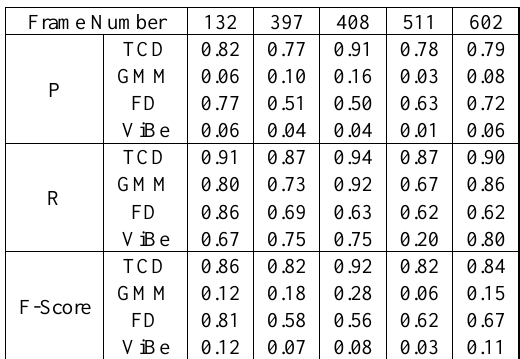
Table 2. Evaluation and comparison of each detection algorithm of the Jilin-1 satellite Frame